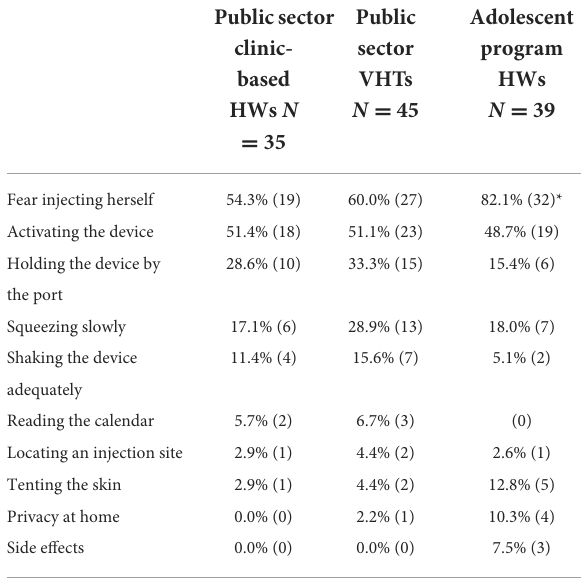
TABLE 3 Health worker-reported challenges for clients learning to self-inject